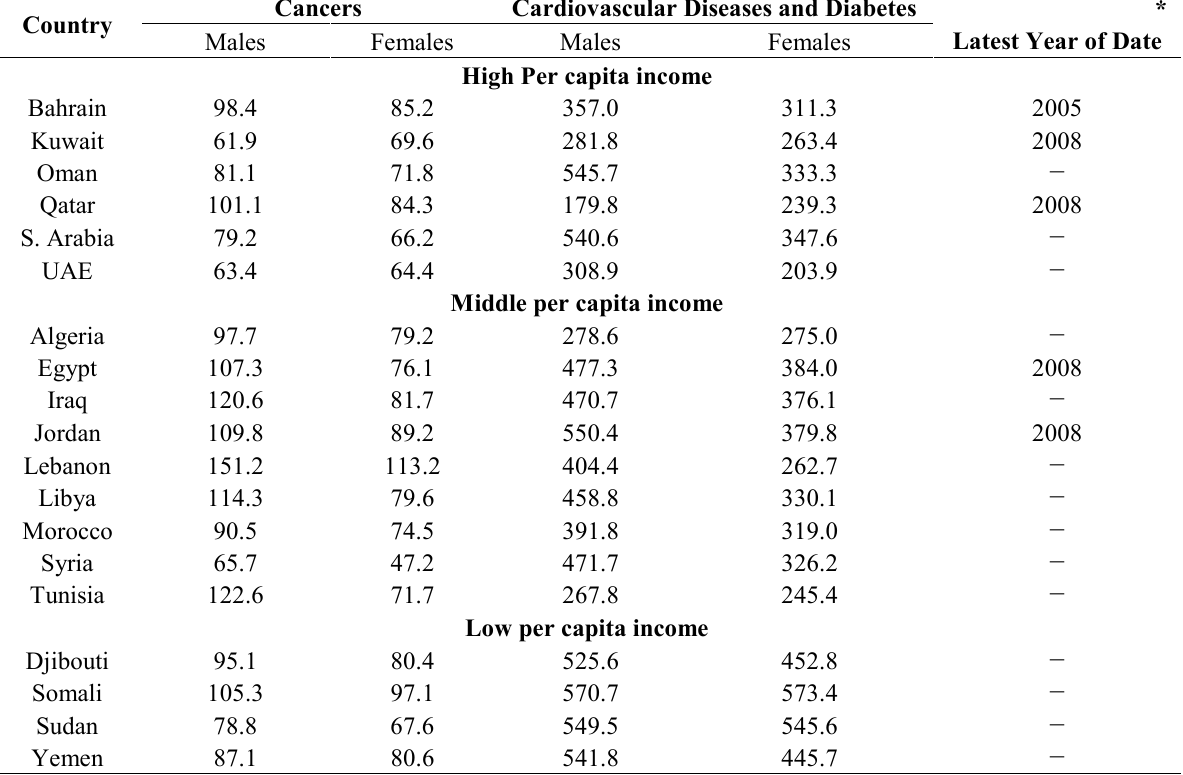
* Countries with no latest year of data; the estimate of diseases in these countries was based on a combination of country life table, causes of death models, regional cause of death patterns, and WHO programme estimates for some major causes of death. Source: WHO